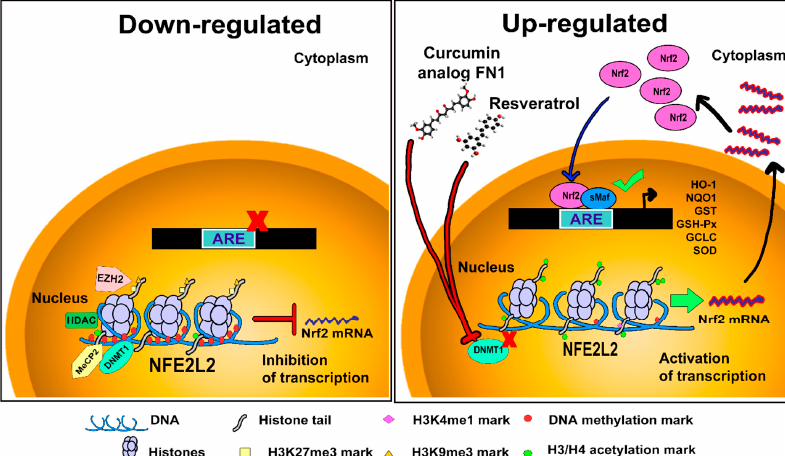
Figure 2. Epigenetic modifications of NFE2L2 . The left panel shows epigenetic modifications that lead to downregulation of NFE2L2 . Hypermethylation of both, DNA and histones, reduces the mRNA expression levels of Nrf2. The right panel shows that hypomethylation and acetylation of histones increase the mRNA expression levels of Nrf2 and consequently the activation of cytoprotective genes. Resveratrol and curcumin analog (FN1) reduce the activity of DNMT1 and increase the activity of HDACs, promoting the expression of Nrf2.